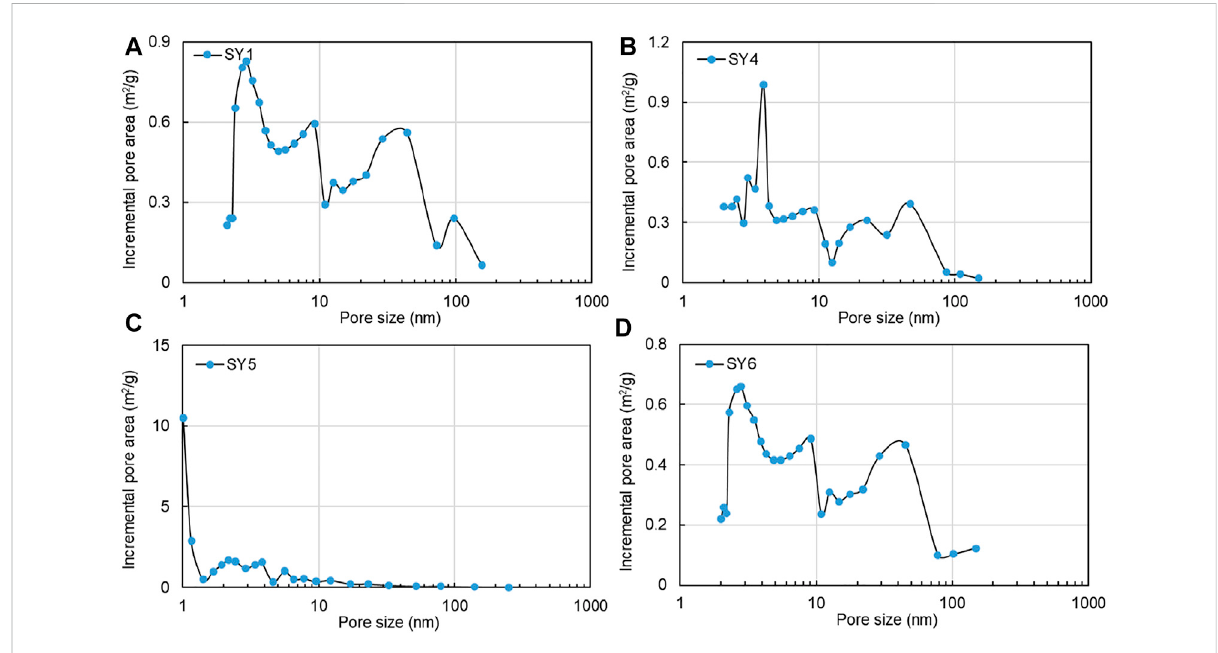
FIGURE 7 Incremental pore area versus pore size of typical shale